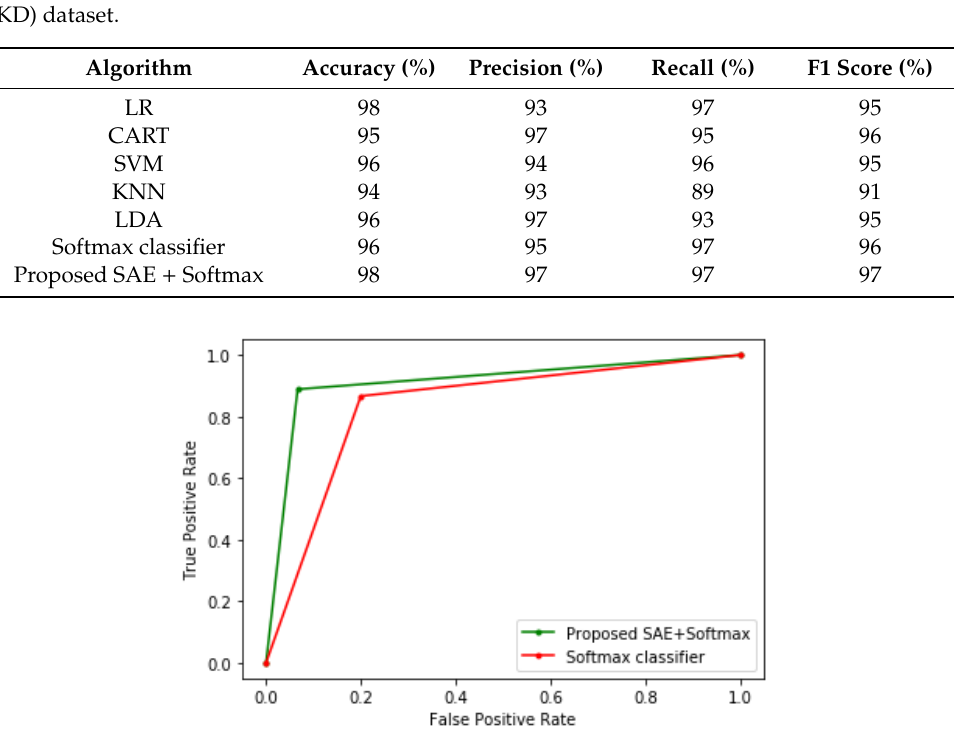
Figure 3. Receiver operating characteristic (ROC) curve of the heart disease model. Table 2. Performance of the proposed method and other classifiers on the cervical cancer dataset .